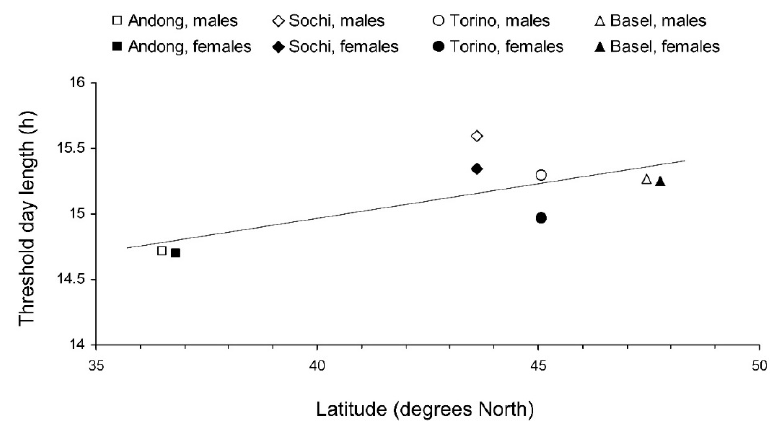
Figure 6. Interrelations between the latitude of the origin and the critical day length for the induction of reproductive diapause in Halyomorpha halys adults from different populations at 24 °C. Each symbol represents values for 1 sex from 1 population (Linear regression: Y = 0.052X + 12.9; r = 0.718, n = 8, p = 0.045). Some symbols are slightly shifted horizontally to avoid overlap.